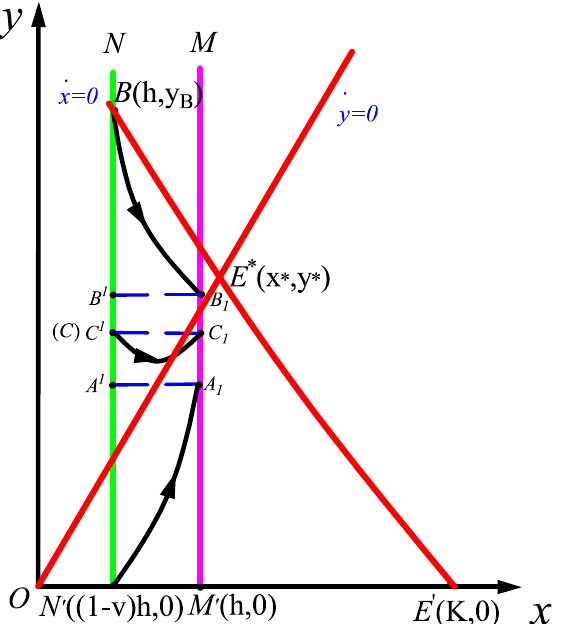
Figure 2. Existence and uniqueness of order-one periodic orbit if 0 < ( 1 − v ) h < h < x ∗ < K holds. (2) If 0 < ( 1 − v ) h < x ∗ < h